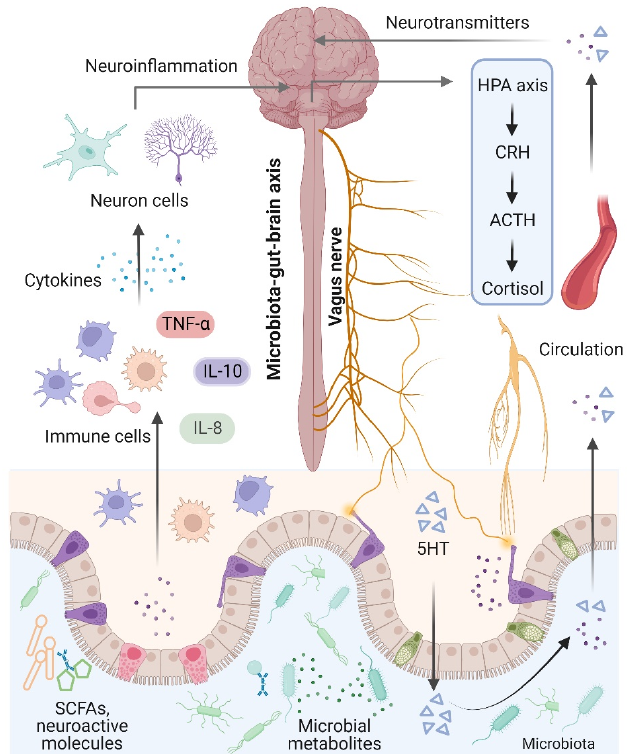
Figure 2. Microbiota–gut–brain axis. The brain and gut communicate through neural, metabolic, endocrine, and immunological pathways. The brain influences gut health through the vagus nerve, the hypothalamic–pituitary–adrenal (HPA) axis, and systemic circulation. Signals from the gut, including short-chain fatty acids (SCFAs), neurotransmitters, and amino acids, modulate brain function via neuronal cells, the immune system, and endocrine